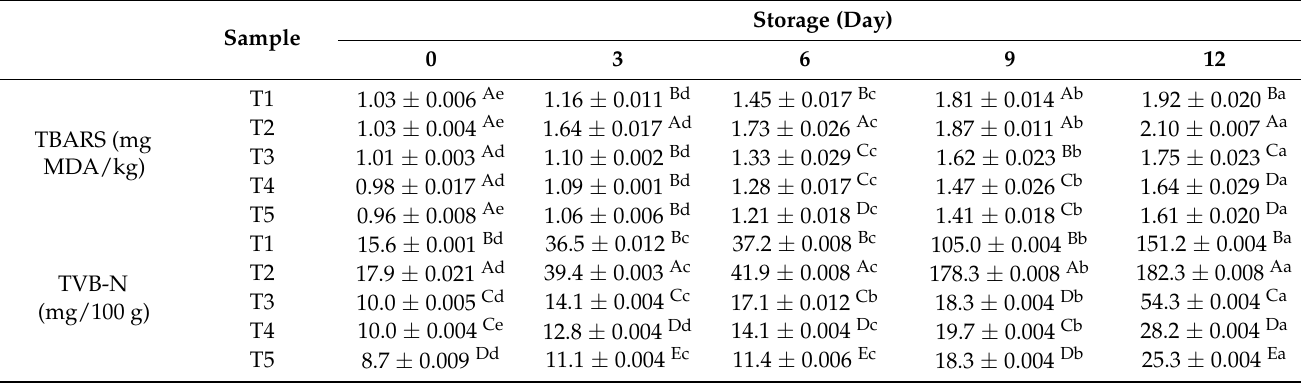
Table 3. Changes in thiobarbituric acid reactive substances (TBARS) and total volatile base nitrogen (TVB-N) values of chicken meat coated with chitosan containing AFEOs during storage at 4 ◦